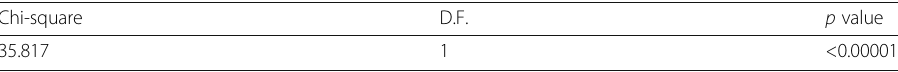
Table 10 Likelihood ratio test statistics